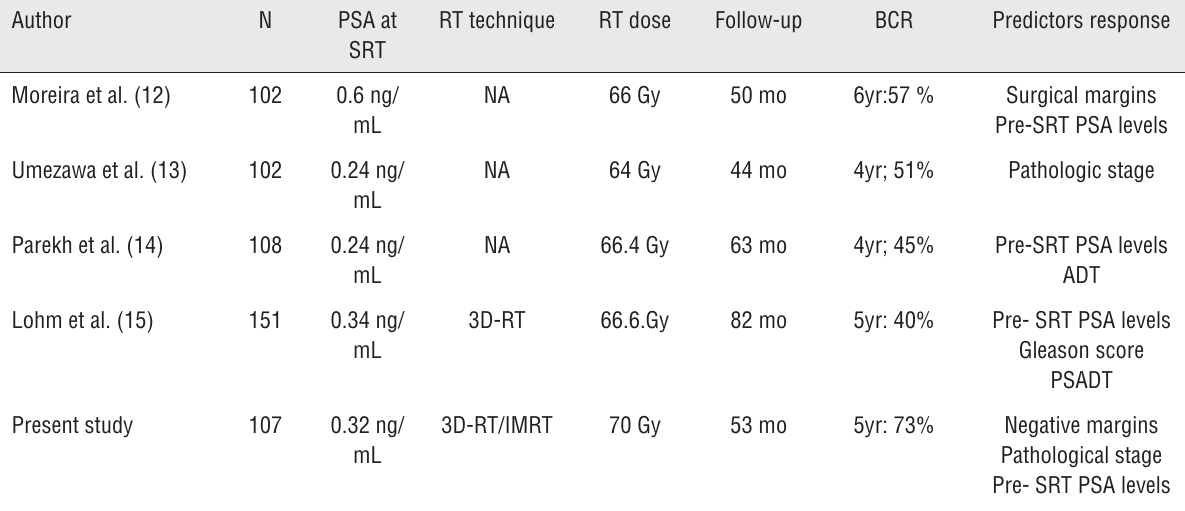
Table-5 - Outcomes with salvage radiotherapy (SRT) from contemporary retrospectives studies in prostate cancer patients undergoing radical prostatectomy (RP) and PSA